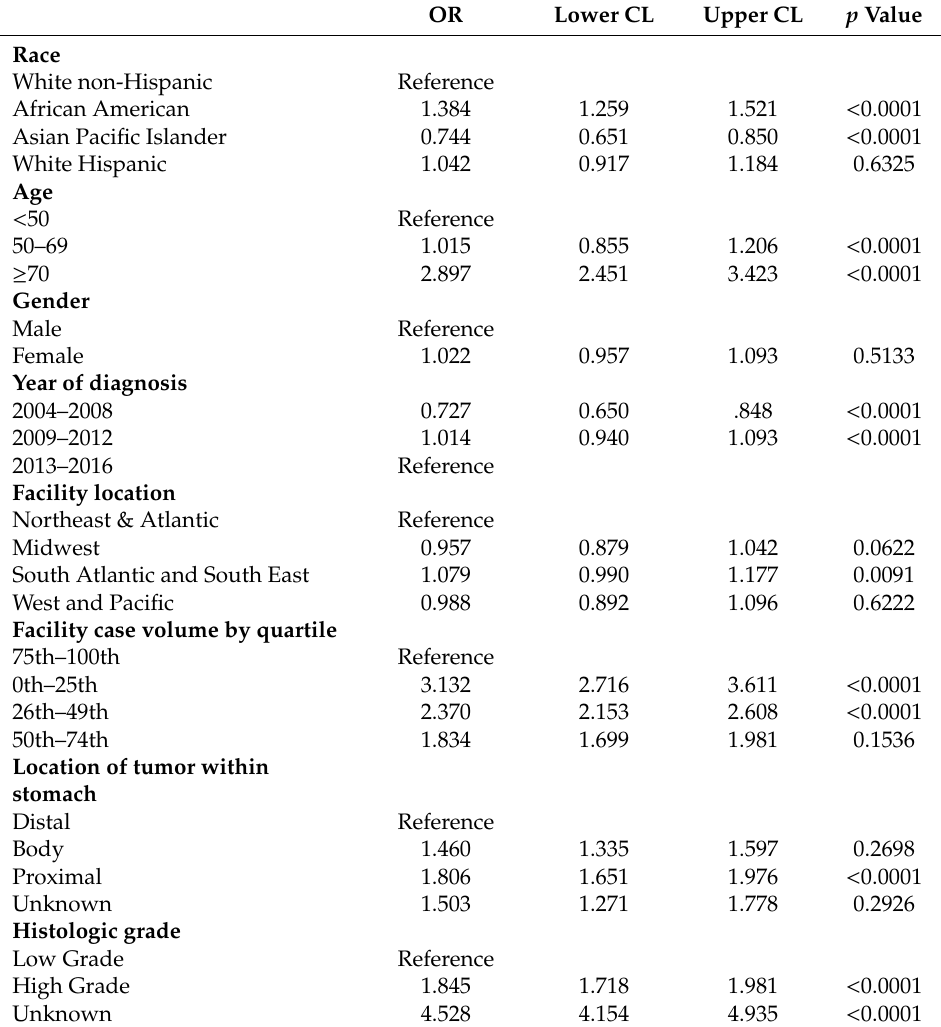
Table 4. Predictors of Non-Standard of Care Received for Stage I Gastric Cancer.